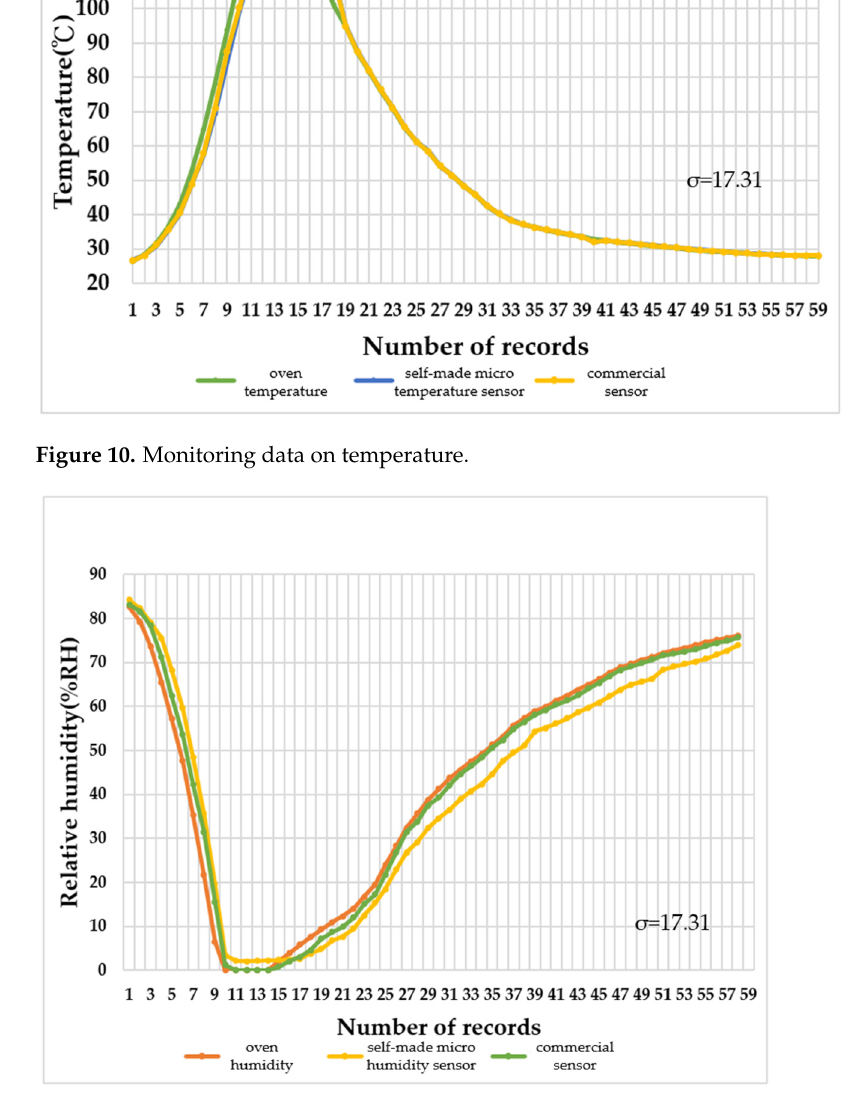
Figure 10. Monitoring data on temperature.